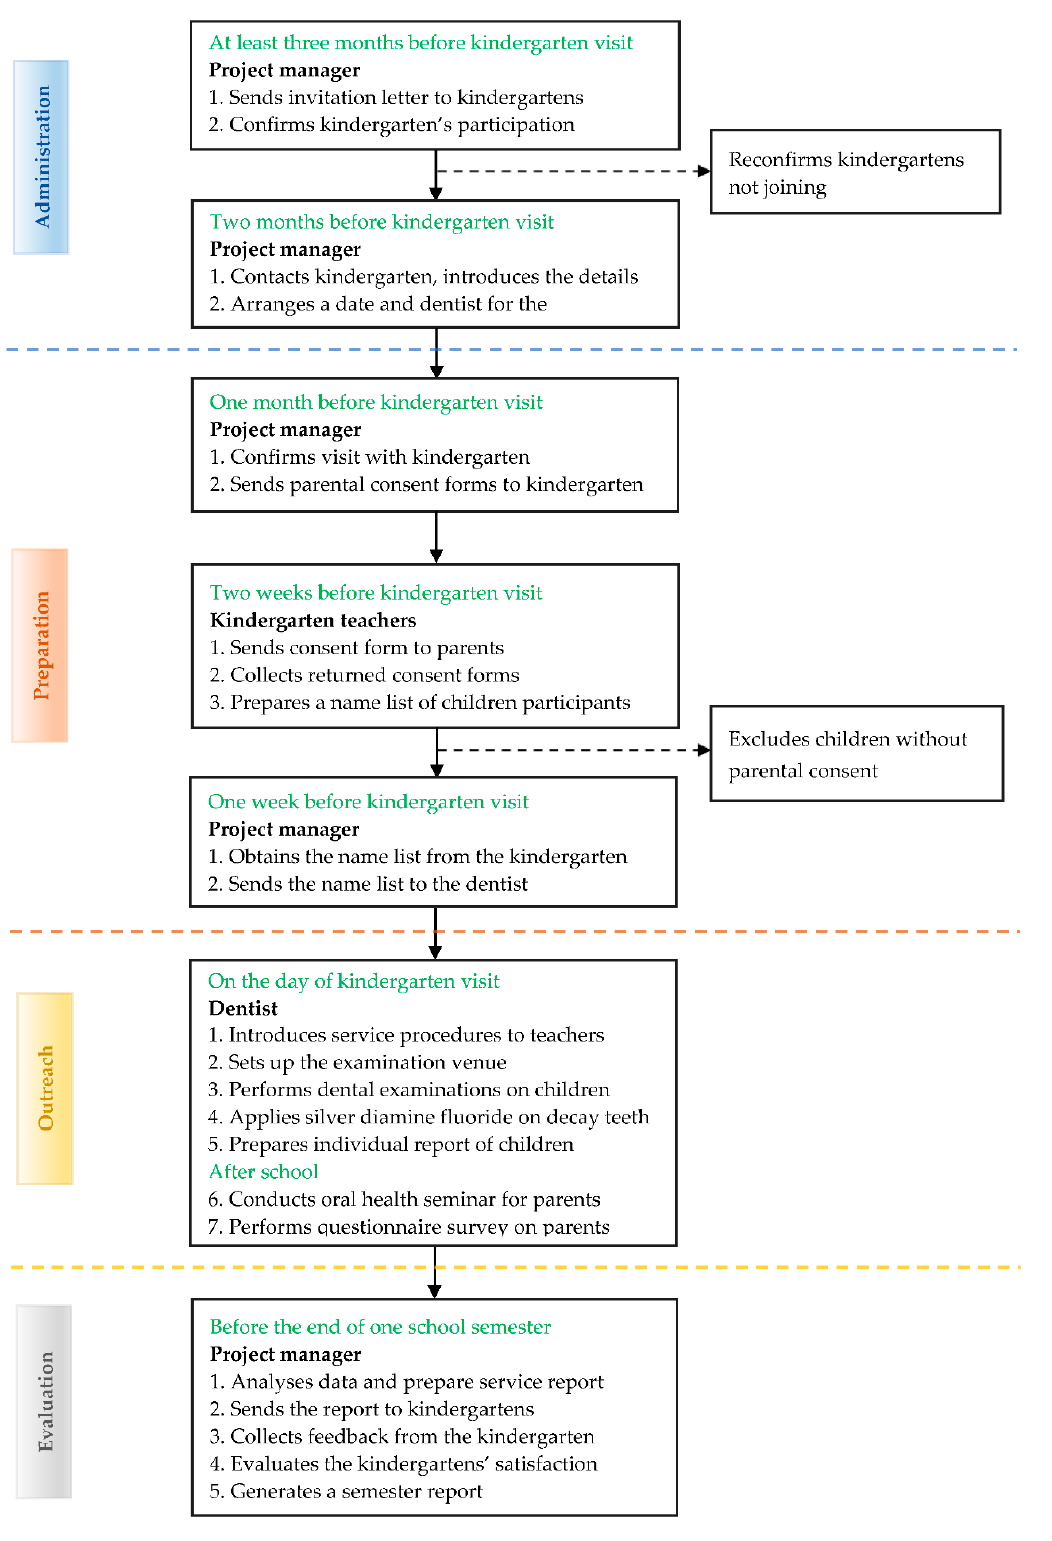
Figure 4. The flow of the kindergarten dental outreach service.